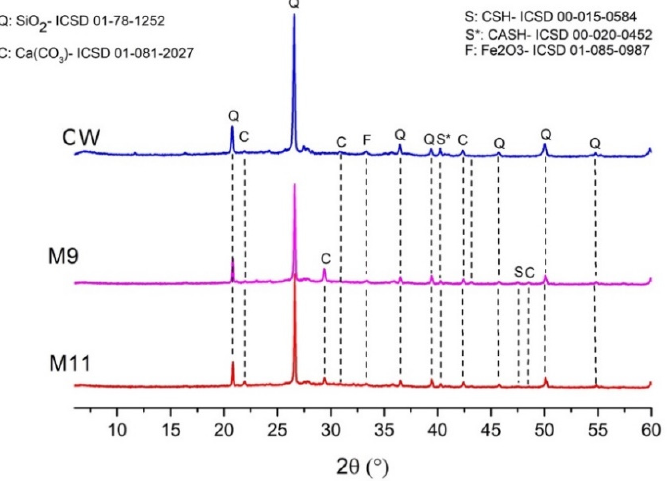
Figure 3. XRD for M9 and M11 mixtures at the age of 90 days compared to the CW raw material.